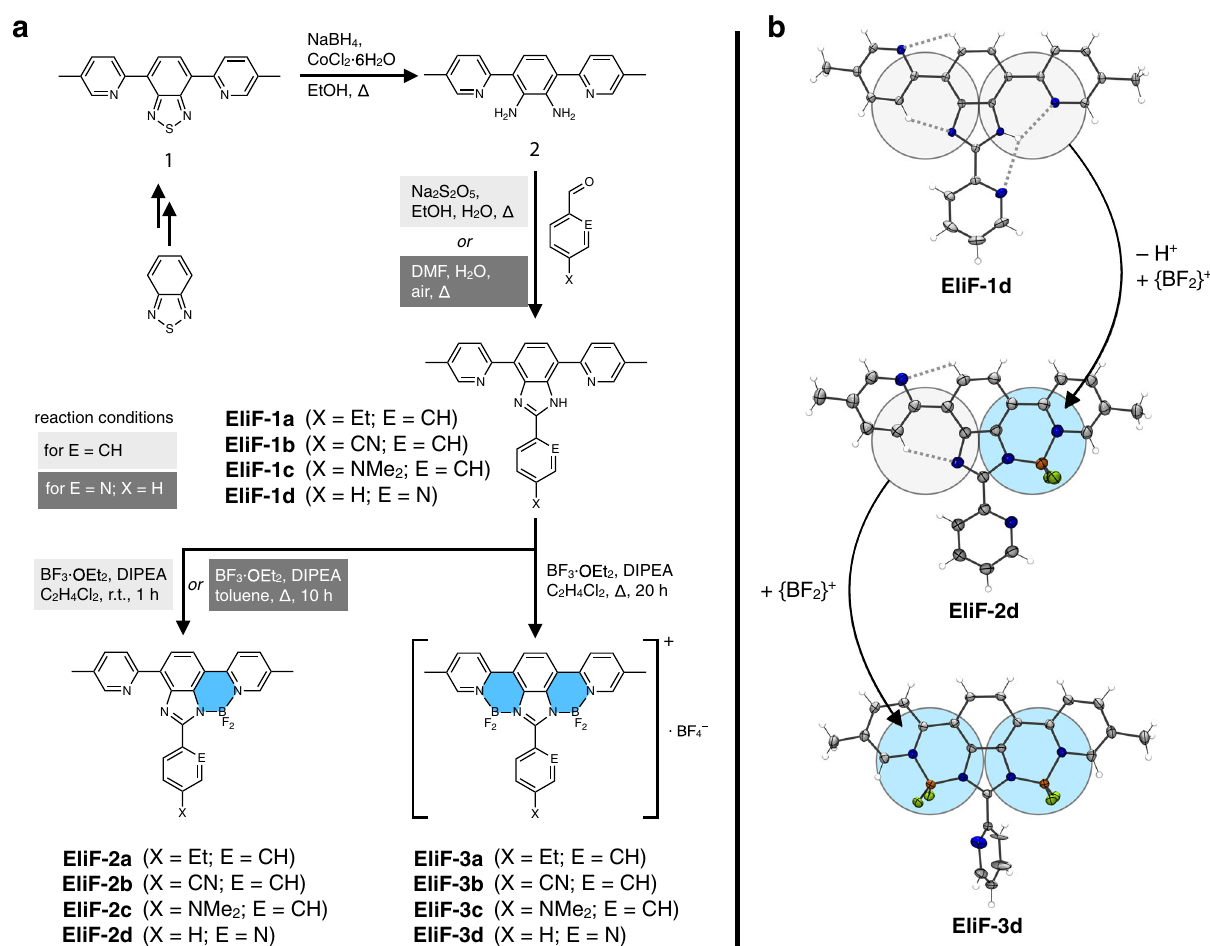
Fig.2|ModularconstructionofEliFmolecules.a Syntheticroutestofreeligandsandstepwiseborylation. b Representativesingle-crystalX-raystructures.Etethyl,DMF N , N -dimethylformamide, Me methyl, DIPEA N , N